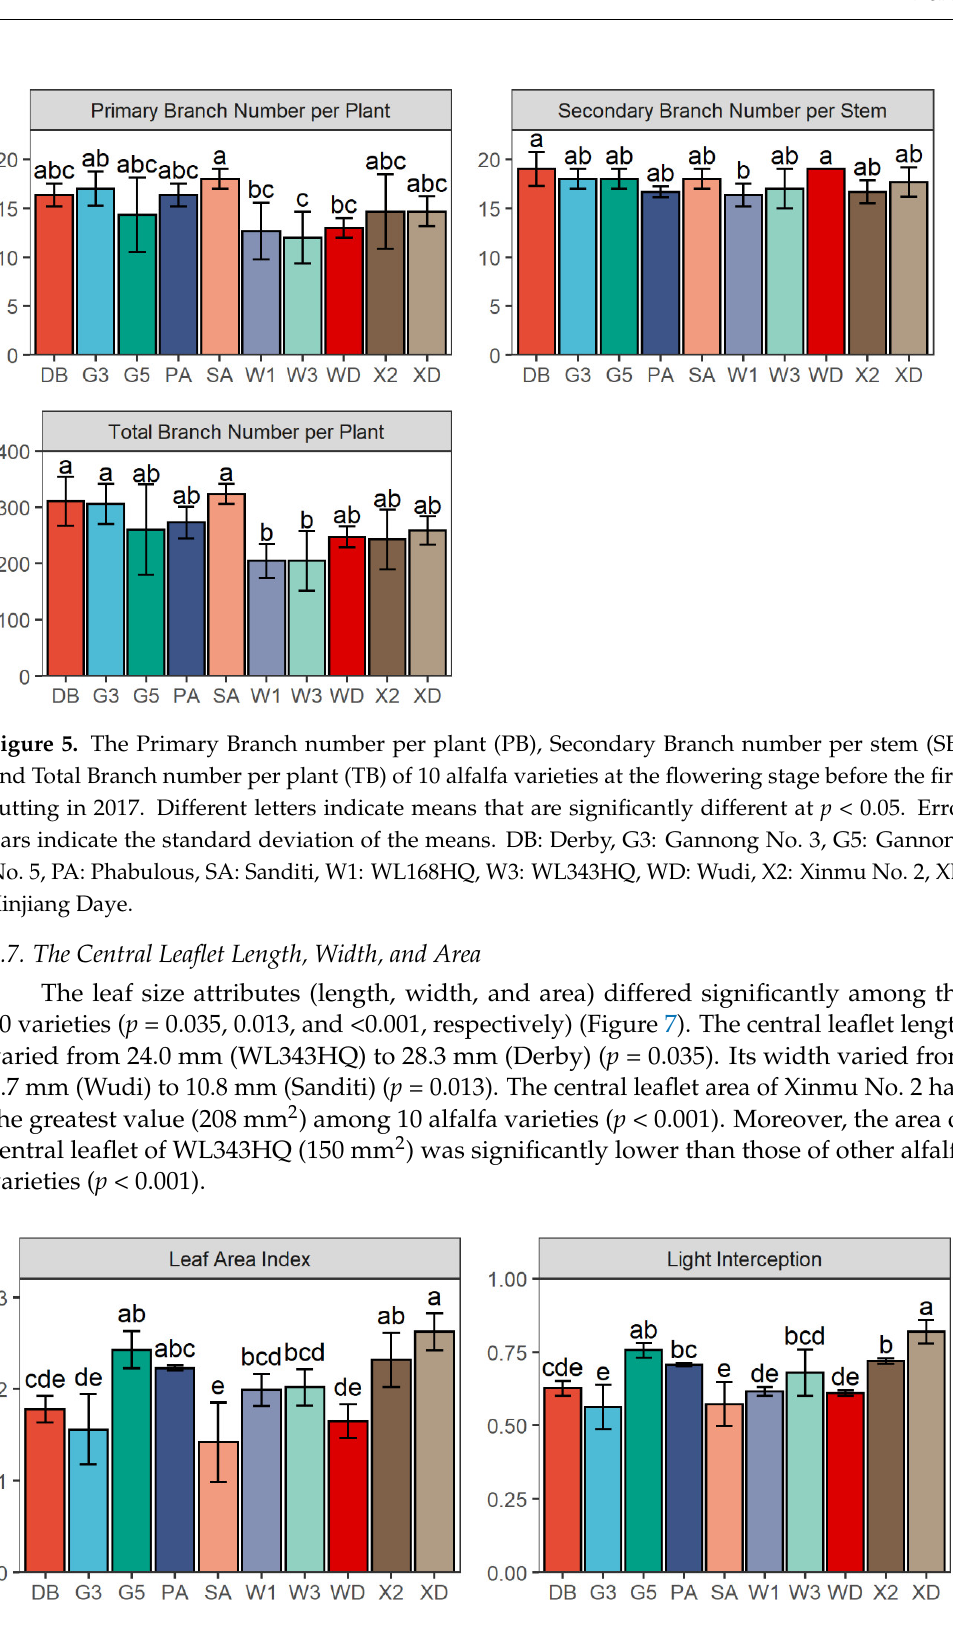
Figure 6. Leaf area index (LAI) and light interception (LI) of 10 alfalfa varieties at the flowering (first cutting) in 2017. Different letters indicate means that are significantly different at p < 0.05. Error bars indicate the standard deviation of the means. DB: Derby, G3: Gannong No. 3, G5: Gannong No. 5, PA: Phabulous, SA: Sanditi, W1: WL168HQ, W3: WL343HQ, WD: Wudi, X2: Xinmu No. 2, XD: Xinjiang